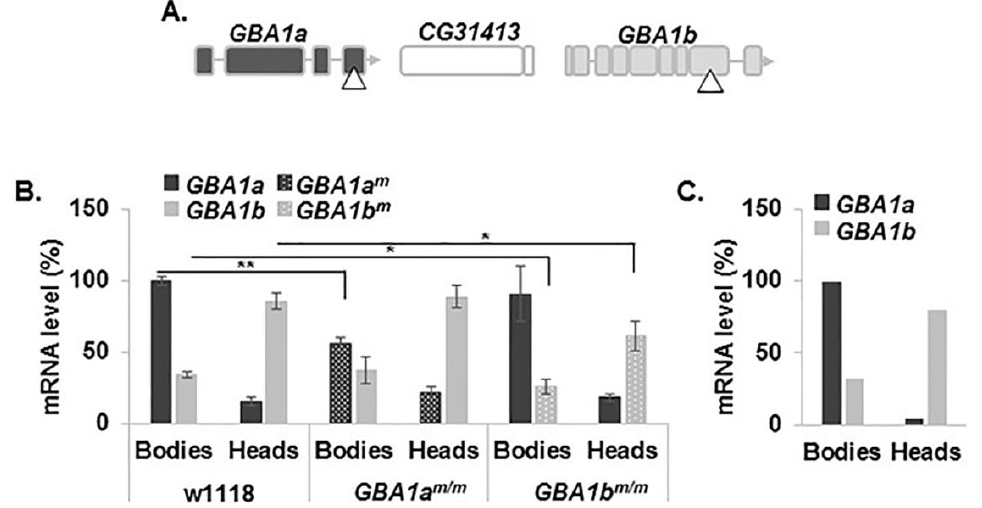
Figure 1. Expression of the two normal and the two mutant Drosophila GBA1 genes. ( A ) Schematic representation of the GBA1 genes locus. GBA1a is located 2 kb upstream of GBA1b . CG31413 is a non-relevant gene between them. Triangle represents the Minos element insertion site in each gene. Exons of GBA1a appear in dark grey and those of GBA1b -in light grey. ( B ) Expression of normal ( GBA1a and GBA1b ) and mutant ( GBA1a m and GBA1b m ) GBA1 alleles in bodies and heads of control (w1118), GBA1a m/m and GBA1b m/m flies as analyzed by quantitative Real Time-PCR (qRT-PCR). Presented is the average ± standard error of five independent experiments. Expression of GBA1a in w1118 was considered 100%. * p < 0.05, ** p < 0.01. ( C ) FlyBase deep sequencing data summary (expression by tissue). Only the two highest expressed exons were counted.